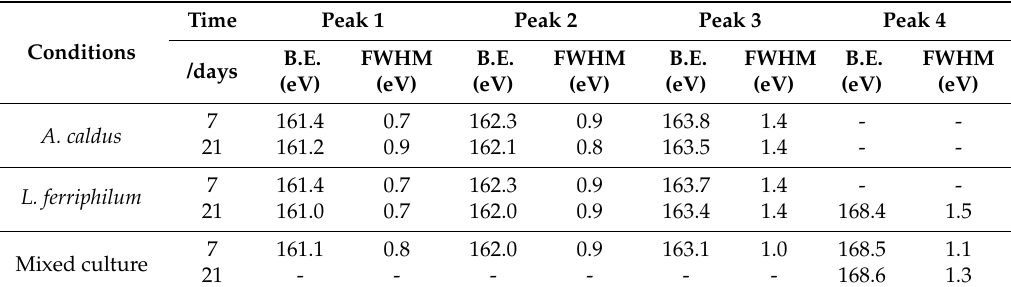
Table 6. Binding energy and FWHM value for XPS spectra of S 2p 3/2 peaks of bornite leached by A. caldus , L. ferriphilum and mixed culture consisting of A. caldus and L. ferriphilum for 7 and 21 days, respectively (Implemented on the model of ESCALAB 250Xi of Al K α X-ray source with 20 eV constant pass energy and 0.1 eV/step; Fitted by Thermo Avantage 5.52, C 1s 284.8 eV as reference, Shirley method, Gaussian-Lorentzian function) (FWHM means full width at half maximum, B.E. means binding energy).